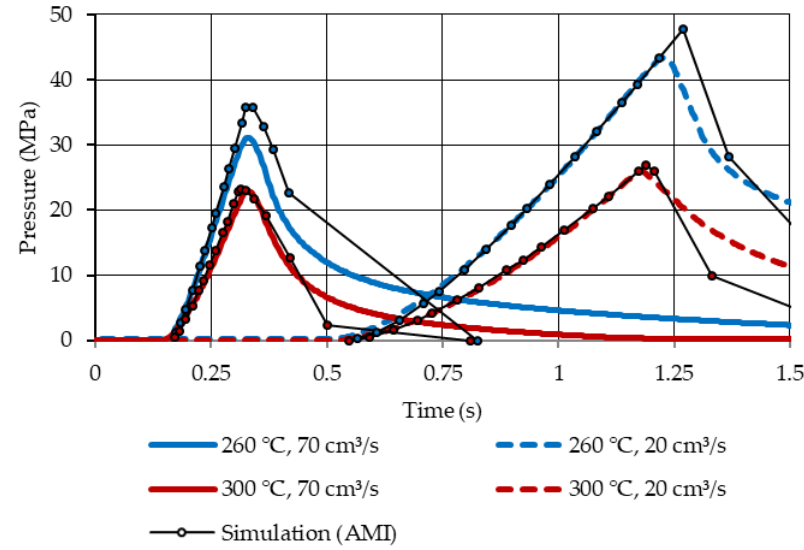
Figure 9. Comparison of the recorded (in blue and red) and simulated (in black) pressure curves for short shots (no packing pressure applied) with the 2 mm plate mold at different melt temperatures and injection speeds. The positioning of the pressure sensor is marked with a blue arrow in Figure 3 (the mold temperature was set to 100 ◦